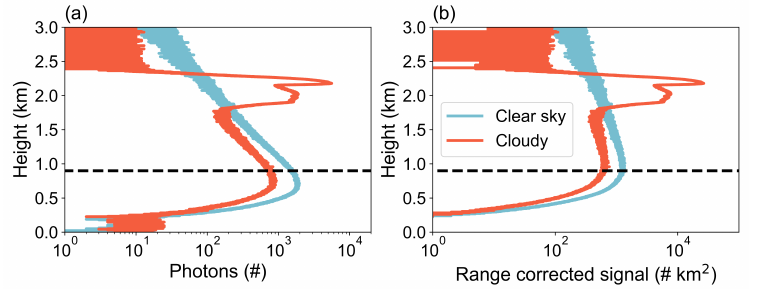
Figure 5. ( a ) Raw signal and ( b ) range-corrected photons received by the T2 lidar operated in continuous mode. The returns with a clear sky after sunset at 9 pm LT on 20 June 2022 (blue line) and a cloudy sky after sunset at 8:40 p.m are shown. LT on 21 June 2022 (red line). The arrival time data of received photons were binned to 1 ns, corresponding to the range resolution of 15 cm. The horizontal dashed line indicates the minimum full overlap height of about 900